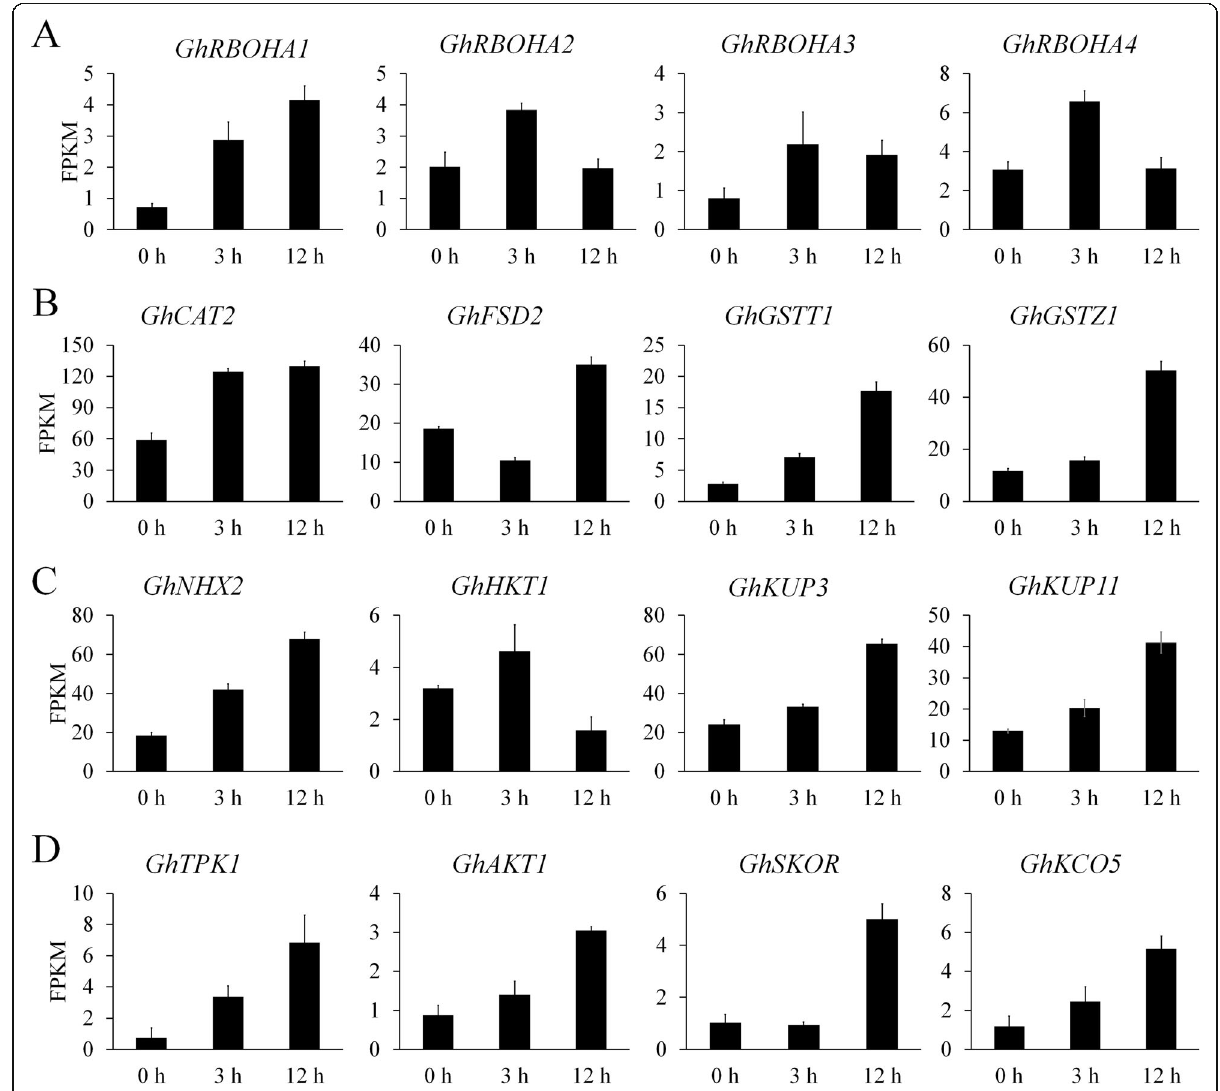
Fig. 5 The expression patterns of genes involved in antioxidant and ion transport systems. a-b Expression patterns of genes related to reactive oxygen species production and scavenging. c-d Expression patterns of ion transport related